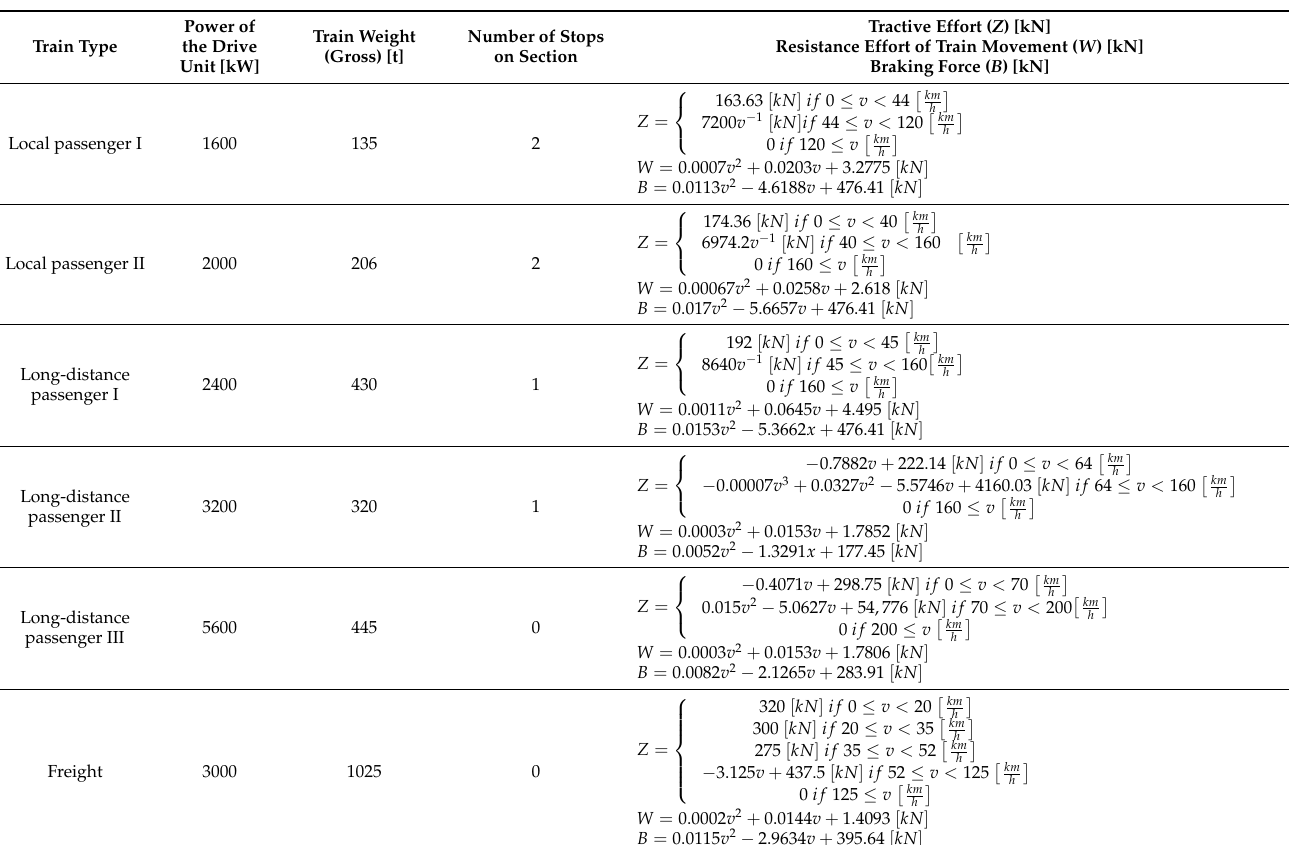
Table 3. Main characteristics of trains running on the railway